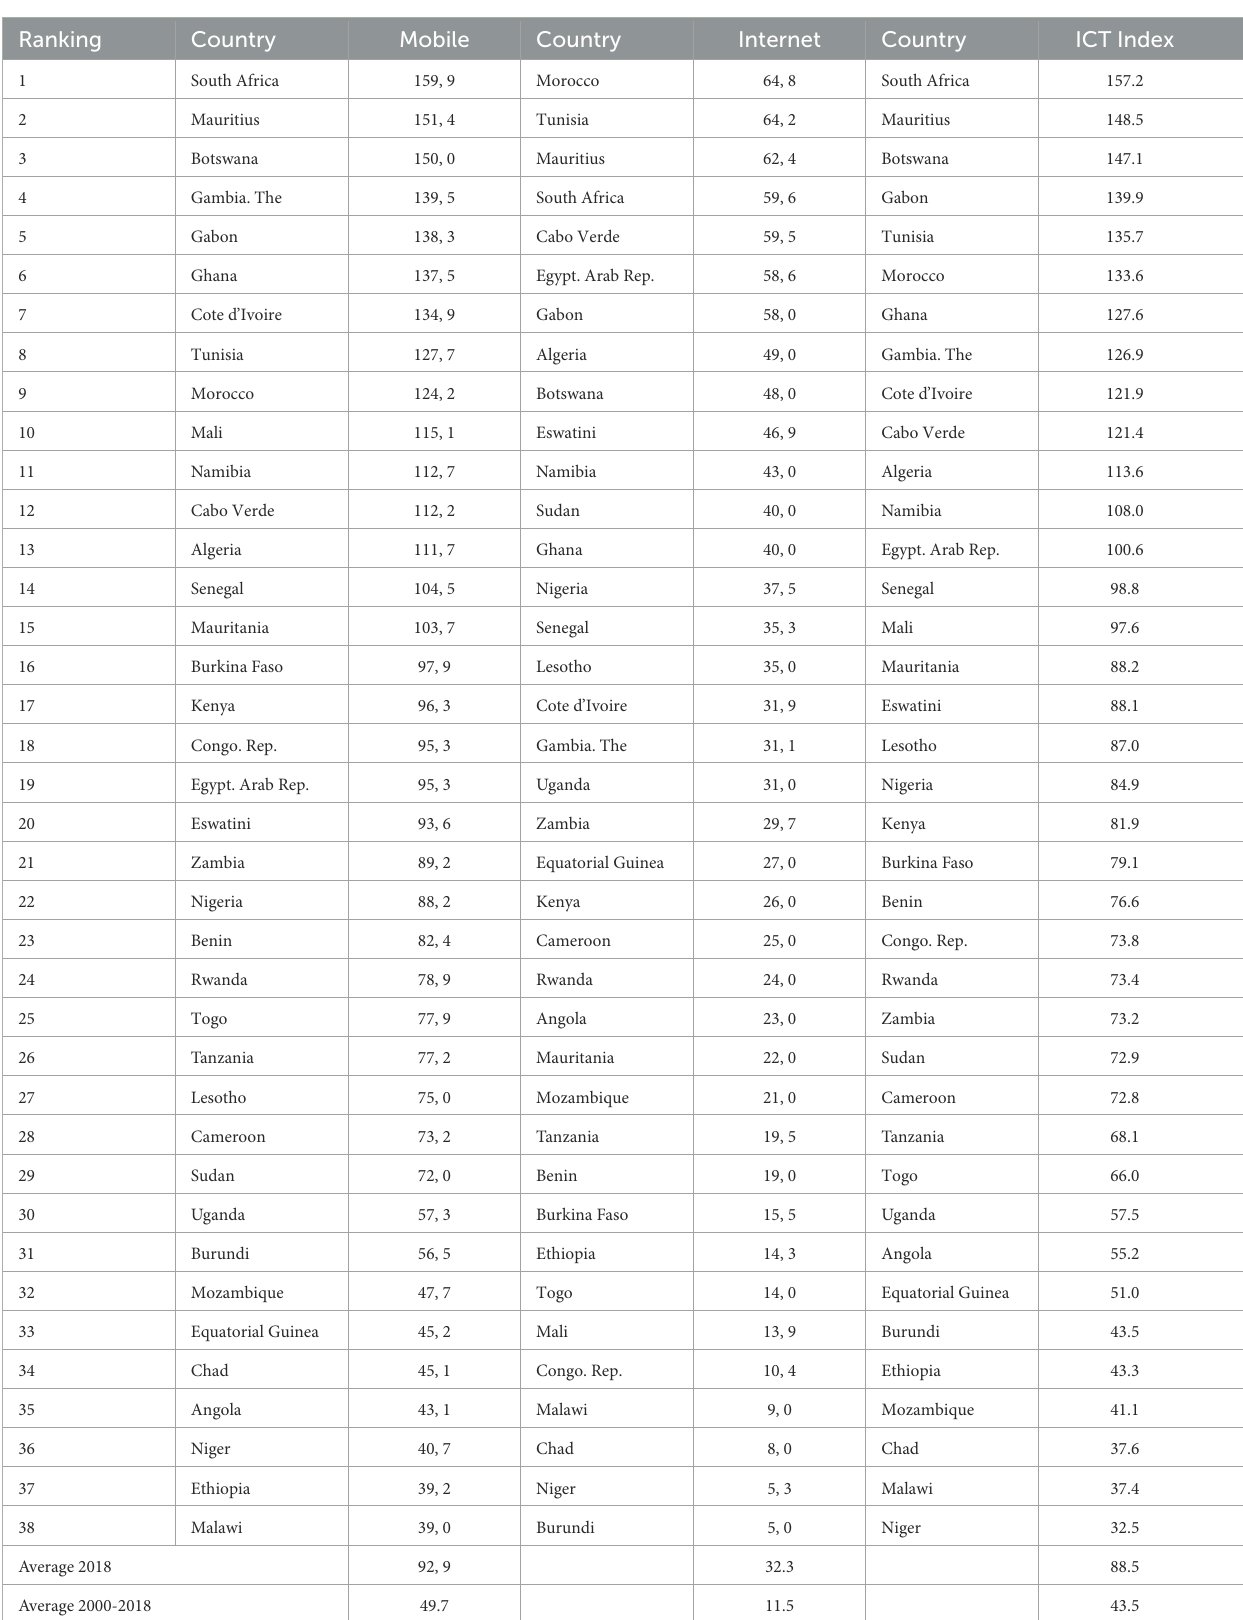
TABLE 1 Ranking of ICT development at